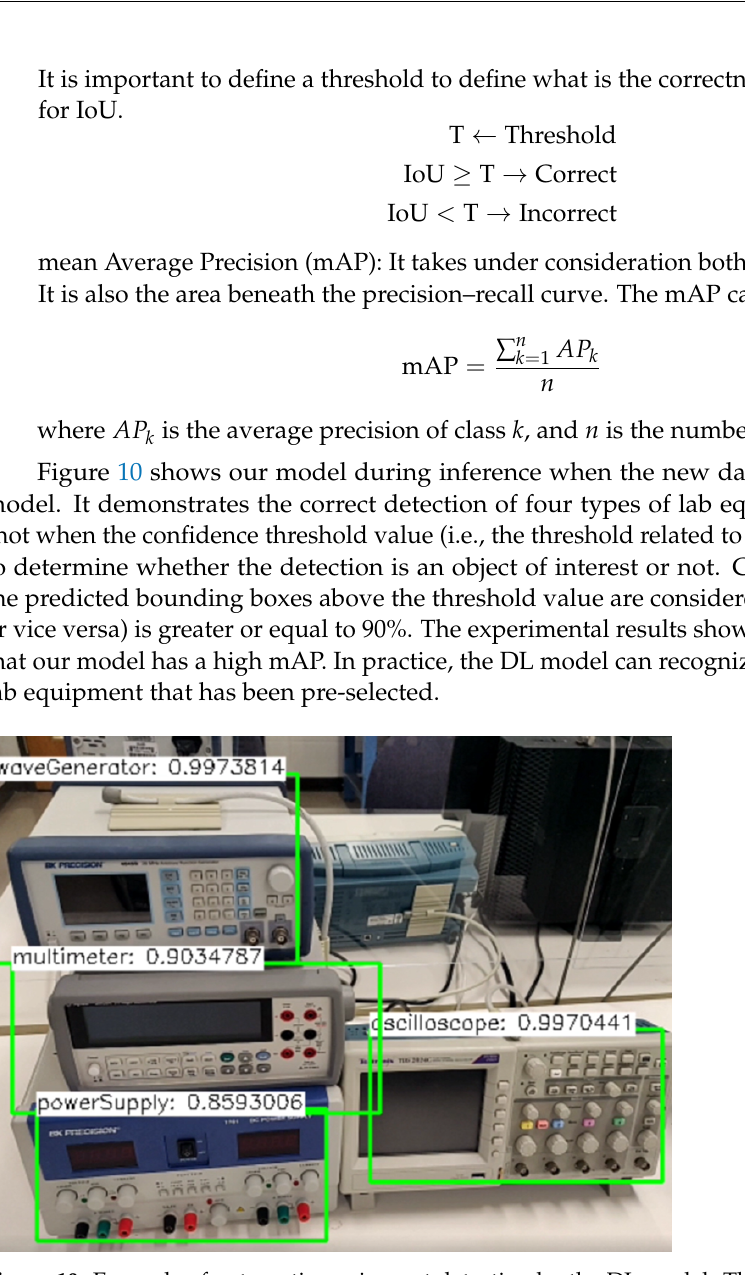
Figure 10. Example of automatic equipment detection by the DL model. The number above each green bounding box indicates confidence score of the model, which is the probability that a bounding box contains an object of interest, for the detection. Table 2. Mean average precision (mAP) with different IoU scores of the trained MobileNet-SSD V2